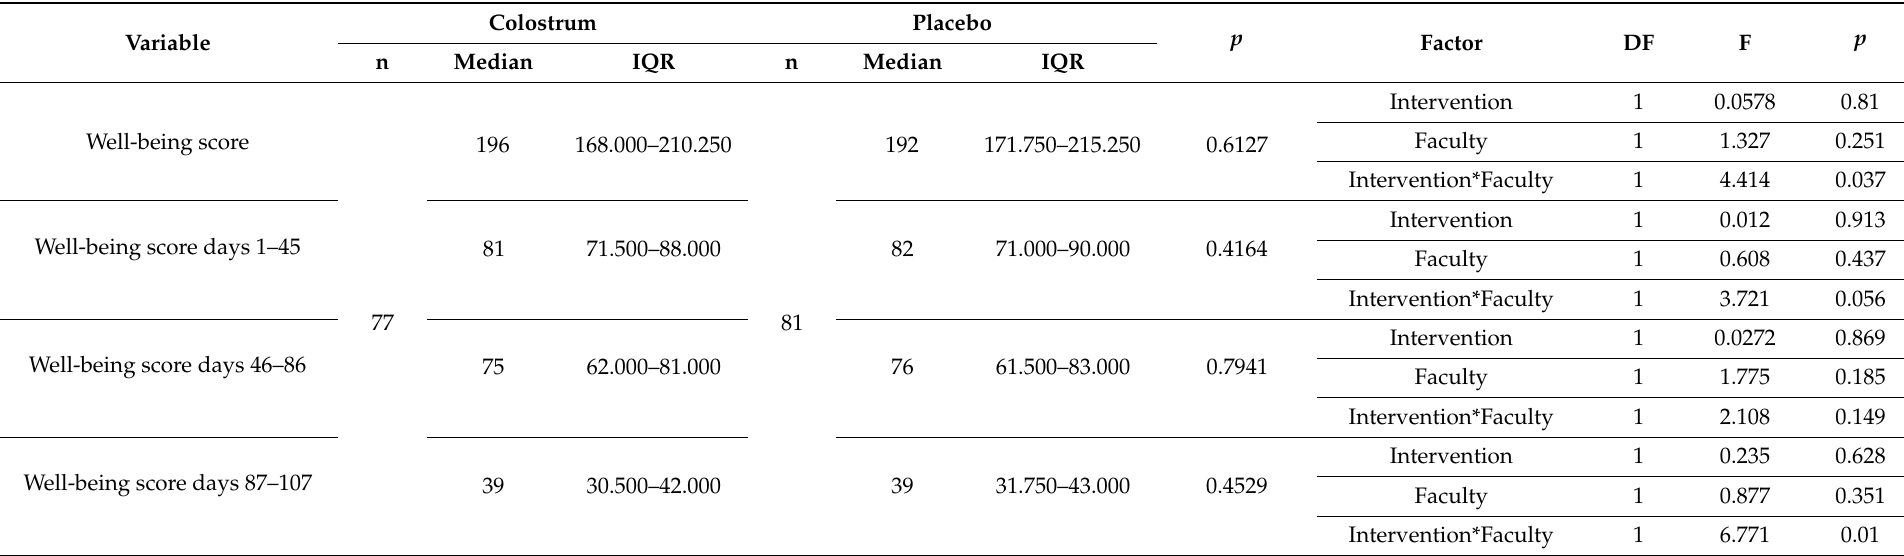
Table 3. The interaction between allocation and faculty for well-being score in three periods as well as over the entire